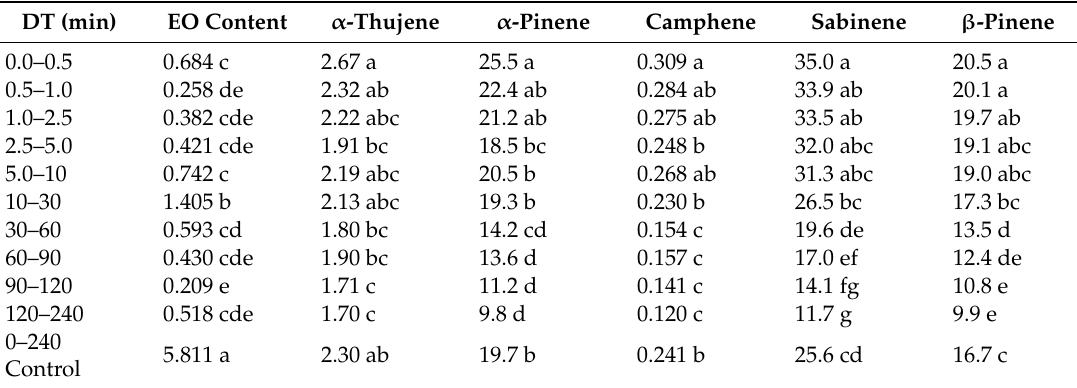
Figure 1. Gas chromatography-flame ionization detector (GC–FID) representative chromatogram from 0 to 240 min distillation time with α -thujene ( 1 ), α -pinene ( 2 ), camphene ( 3 ), sabinene ( 4 ), β -pinene ( 5 ), myrcene ( 6 ), α -phellandrene ( 7 ), 3-carene ( 8 ), α -terpinene ( 9 ), p -cymene ( 10 ), limonene ( 11 ), γ -terpinene ( 12 ), terpinolene ( 13 ), terpinen-4-ol ( 14 ), safrole ( 15 ), and myristicin ( 16 ) indicated. Table 1. Mean essential oil (EO) content (%) and concentration (%) of α -thujene, α -pinene, camphene, sabinene, and β -pinene obtained from ten hydrodistillation timeframes (DT) and control (straight 240